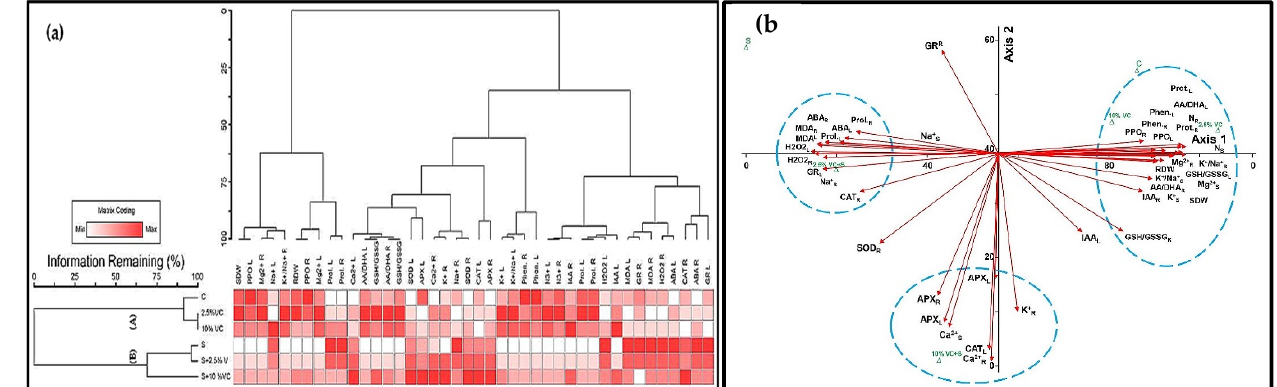
Figure 3. Hierarchical clustering and principal component analysis (PCA) to understand treatment-variable relationships in broad bean plants under both normal and saline conditions. ( a ) The mean values of different parameters were normalized and clustered. Two distinct clusters at the treatment levels (A, B) were detected. Color scale shows the intensity of the normalized mean values of different parameters. ( b ) The whole dataset was analyzed using PCA. The lines originating from the central point of biplots show negative or positive correlations of different variables, where their closeness reveals correlation strength with a particular treatment. The variables included RDW (root dry weight), SDW (shoot dry weight), Ca 2+ R (calcium root), Ca 2+ L (calcium leaf), Mg 2+ R (magnesium root), Mg 2+ L (magnesium leaf), K + R (potassium root), K + L (potassium leaf), N 3+ R (nitrogen root), N 3+ L (nitrogen leaf), Na + R (sodium root), Na + L (sodium leaf), K + /Na + R (potassium/sodium root), K + /Na + L (potassium/sodium leaf), Prot. R (protein root), Prot. L (protein leaf), MDA R (malondialdehyde root), MDA L (malondialdehyde leaf), H 2 O 2 R (hydrogen peroxide root), H 2 O 2 L (hydrogen peroxide leaf), SOD R (superoxide dismutase root), SOD L (superoxide dismutase leaf), CAT R (catalase root), CAT L (catalase leaf), APX R (ascorbate peroxidase root), APX L (ascorbate peroxidase leaf), GR R (glutathione reductase root), GR L (glutathione reductase leaf), AA/DHA R (ascorbic acid/dehydroascorbic acid root), AA/DHA L (ascorbic acid/dehydroascorbic acid leaf), GSH/GSSG R (reduced/oxidised glutathione root), GSH/GSSG L (reduced/oxidised glutathione leaf), Phen. R (phenolics root), Phen. L (phenolics leaf), PPO R (polyphenol oxidase root), PPO L (polyphenol oxidase leaf), IAA R (indoleacetic acid root), IAA L (indoleacetic acid leaf), ABA R (abscisic acid root), ABA L (abscisic acid leaf), Prol. R (proline root), Prol. L (proline leaf).